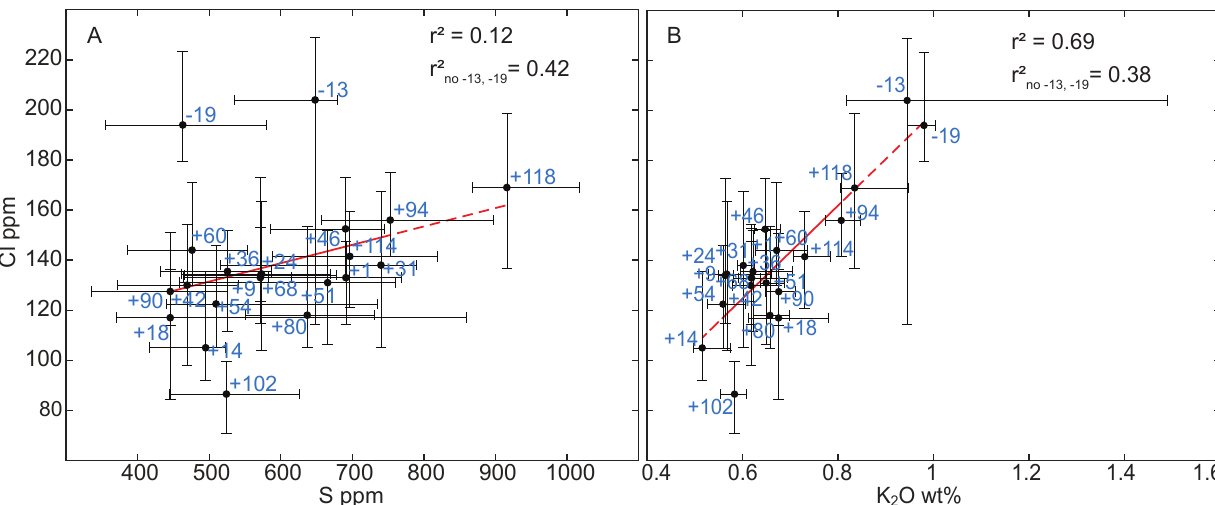
Figure 12: [A] Plot of chlorine as a function of sulfur. [B] Plot of chlorine as a function of K 2 O. Each sample is labelled with ash number, with a dot showing median value and crosses indicating 25 and 75 quartile for X- and Y-axis. Red lines show linear regression for the median values. The r 2 value of the regression is noted both for all ashes, and for only the positive series. Data in Table S1, Supplementary Material.